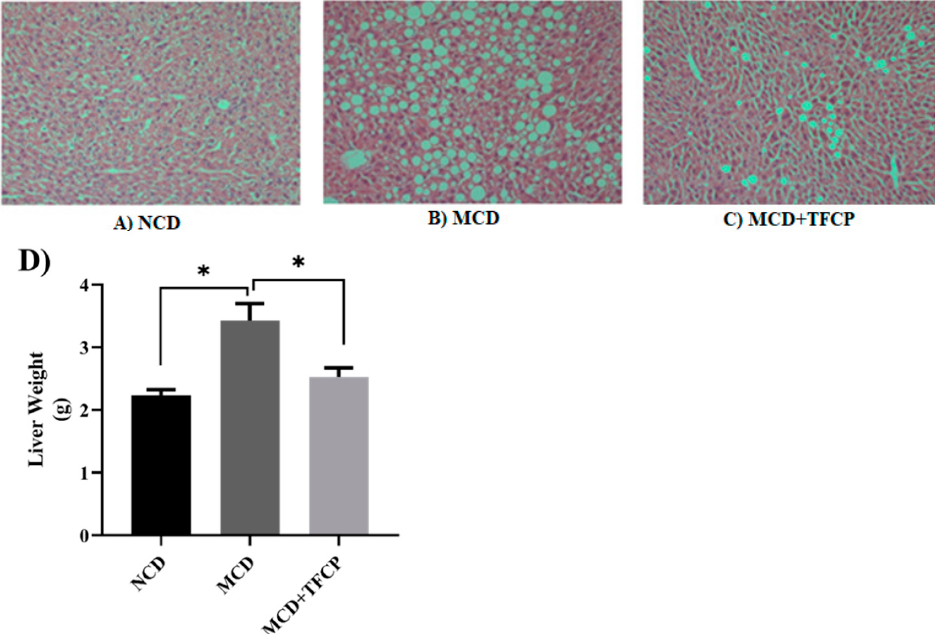
Figure 1. The TFCP-induced attenuation in hepatic lipid deposition and liver weight decline in MCD-fed NAFLD mice. Mice were fed with MCD or the control diet for six weeks, while the intragastric administration of TFCP to MCD-fed mice was performed daily. ( A – C ) The histological analysis of the HE stained liver sections from the mice, demonstrating differential lipid deposition in the livers of the mice in the different groups. ( D ) The graph demonstrates the decline in the liver weight of the NCD-, MCD- and MCD + TFCP-treated groups of mice. The means ± SEM of the results in the graph were obtained using NCD ( n = 5), MCD diet-fed group ( n = 5), and MCD + TFCP ( n = 5). Data were shown as the mean ± SEM (* p < 0.05).